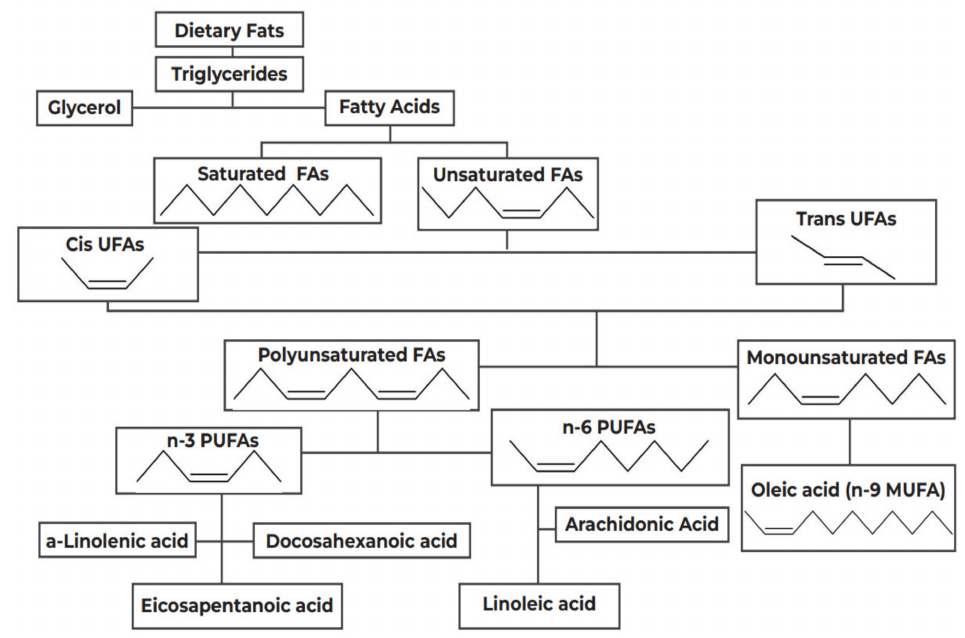
Figure 1. Categorization of dietary fats. FA: Fatty Acids; PUFAs: Polyunsaturated Fatty Acids; MUFA: Monounsaturated Fatty